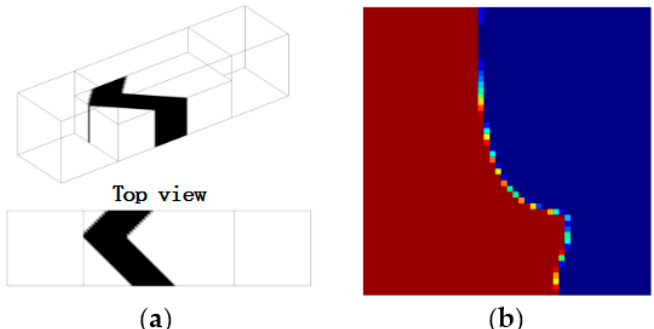
Figure 10. ( a ) Layout of the SHM in the design domain as shown in Figure 4, where n = 2, Re = 2.5, J C = 0.9883; ( b ) the distribution of coarse grain concentration on and the mixing measurement ( ) C the outlet. (the SHM has only one groove and is same volume as the micromixer shown in Figure